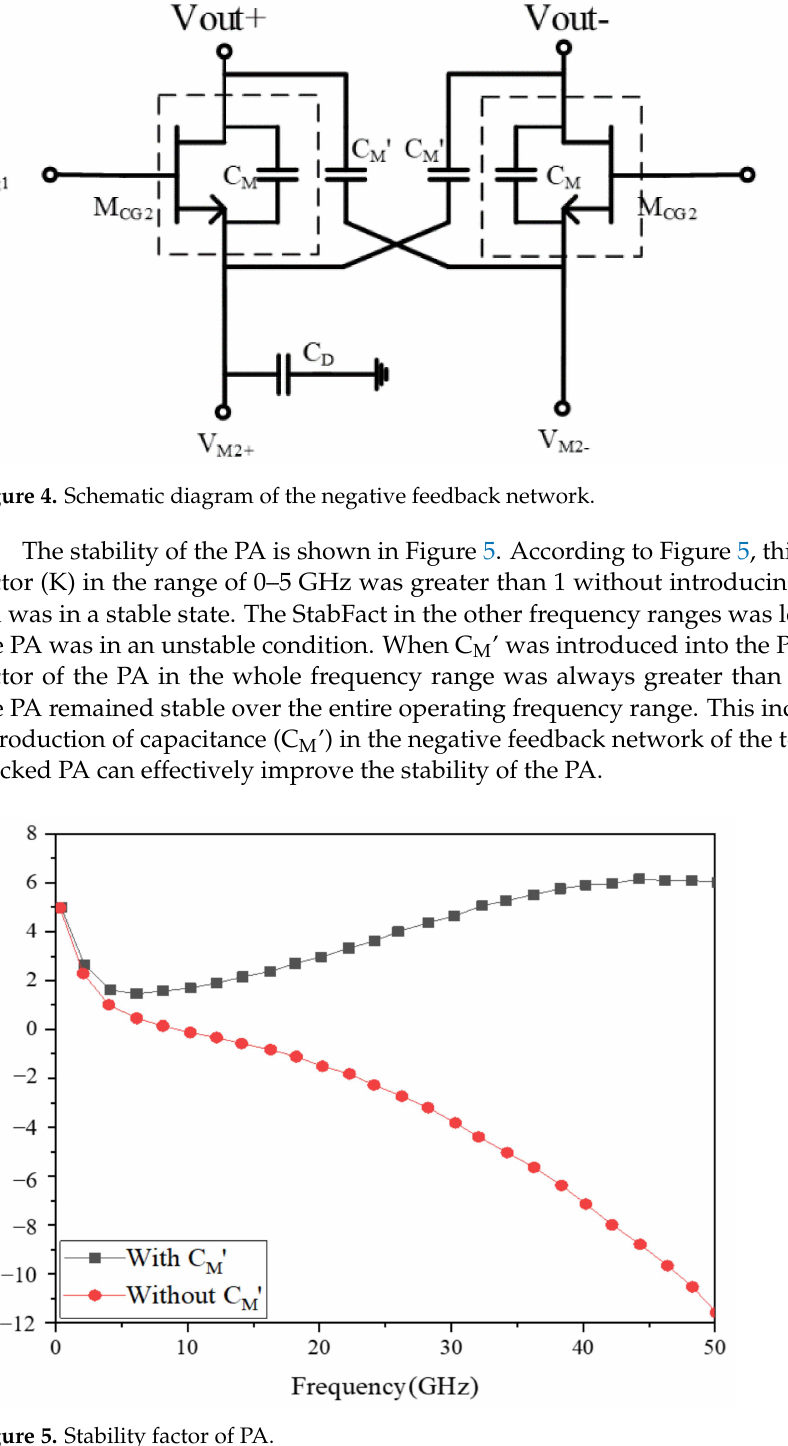
Figure 5. Stability factor of